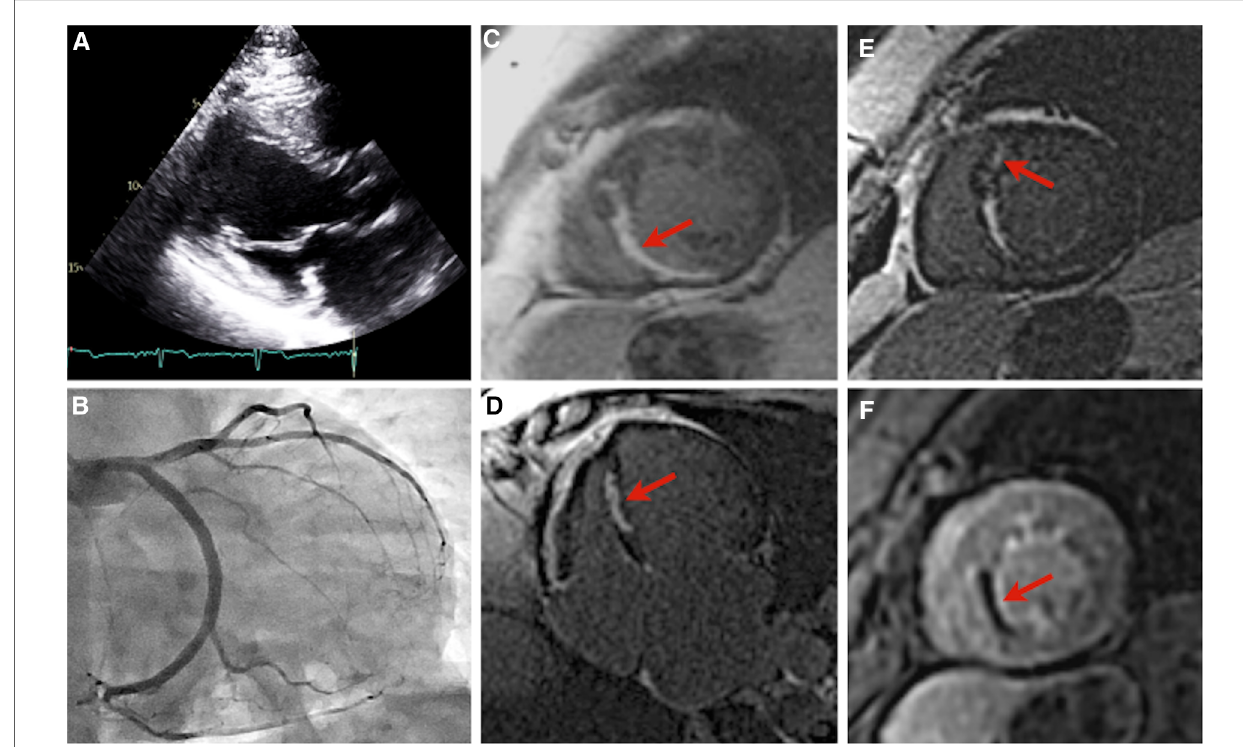
FIGURE 3 Imaging of patient B. Parasternal long axis echocardiogram, with an interventricular septal thickness measurement of 11 mm during diastole, and a patent left ventricular out fl ow tract ( A ). Right anterior oblique caudal angiogram demonstrating a diminutive left anterior descending artery ( B ). Images ( C – F ): cardiac magnetic resonance imaging of patient B. Near-transmural delayed gadolinium enhancement of the mid inferior and inferoseptal wall segments, short-axis view ( C ). Near-transmural delayed gadolinium enhancement of the mid inferior and inferoseptal wall segments, four-chamber view ( D ). Focus of mid-myocardial delayed gadolinium enhancement in the mid anteroseptal wall segment, short-axis view ( E ). Near-transmural septal hypoperfusion, short-axis view ( F